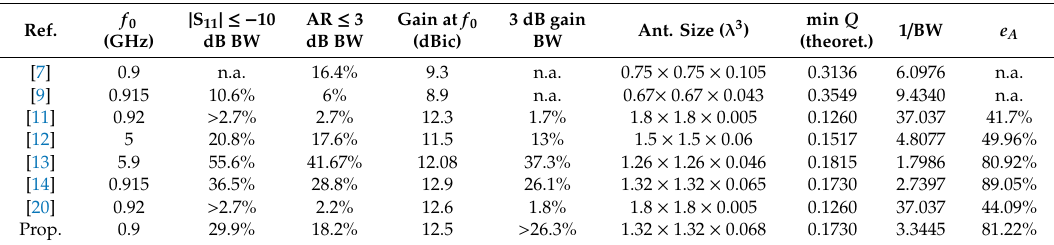
Table 2. Measured performance comparison of the proposed design and other mentioned 2 × 2 circular polarization (CP) antenna arrays.